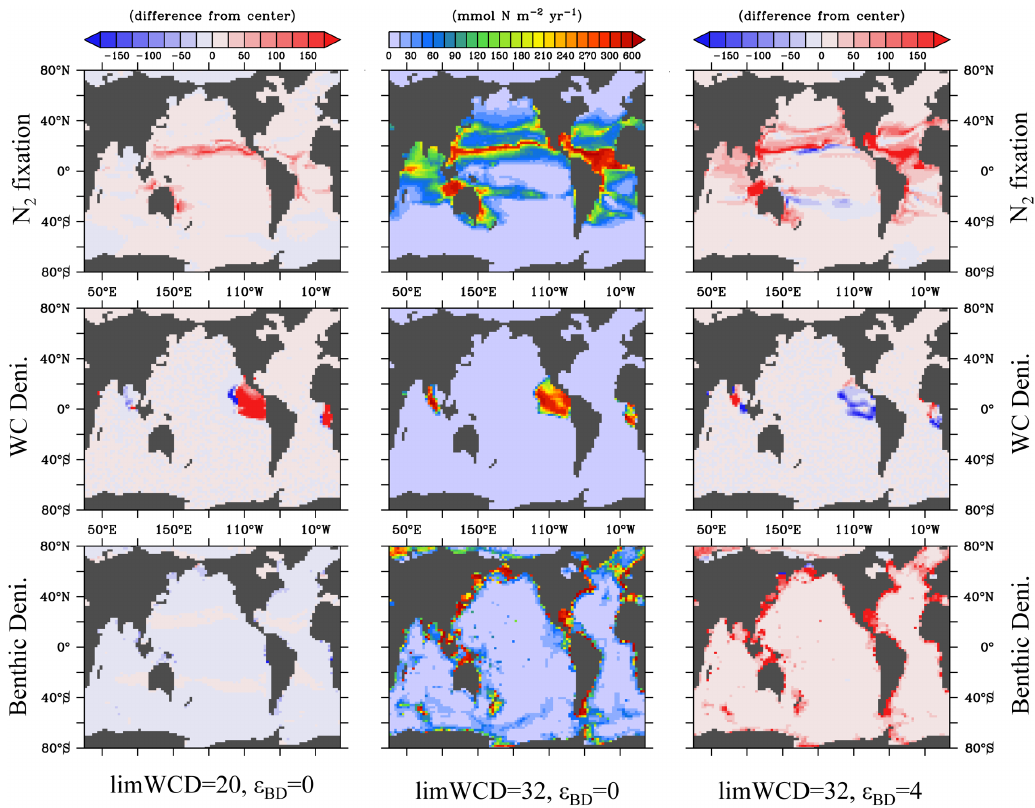
Fig. 2. Global distribution of annual vertically integrated N 2 fixation (top row), water column denitrification (middle row) and benthic denitrification (bottom row) for the experiments limWCD = 20, ε BD = 0 (left); limWCD = 32, ε BD = 0 (center); and limWCD = 32, ε BD = 4 (right). See text for model experiment